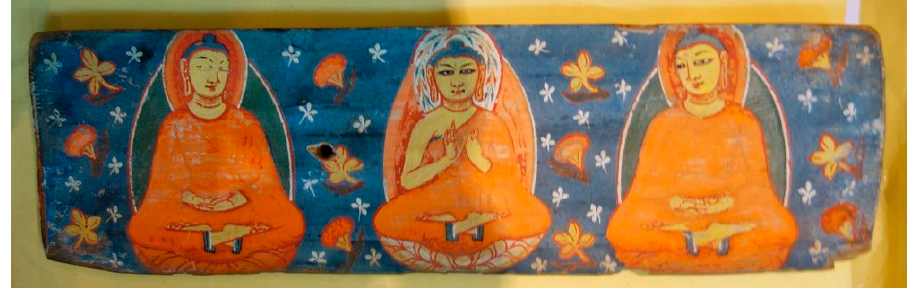
Figure 34. Buddha performing the dharmacakra-pravartana mudr ā . From a pair of painted covers from Manuscript 3, Sa ṃ gh ā ṭ a S ū tra , commissioned by Deva ś irik ā and Atthocasi ṃ gha, 627/628 C.E. Gilgit. Pigment on birch bark. 9” × 3”. Museum of the Institute of Central Asian Studies at Kashmir University, Srinigar, Kashmir. http://travelthehimalayas.com/kiki/2018/7/21/the-gilgit-manuscripts.